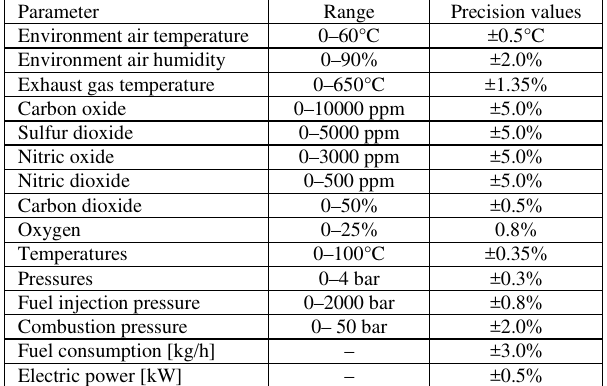
Table 4. Ranges and precisions of measurement